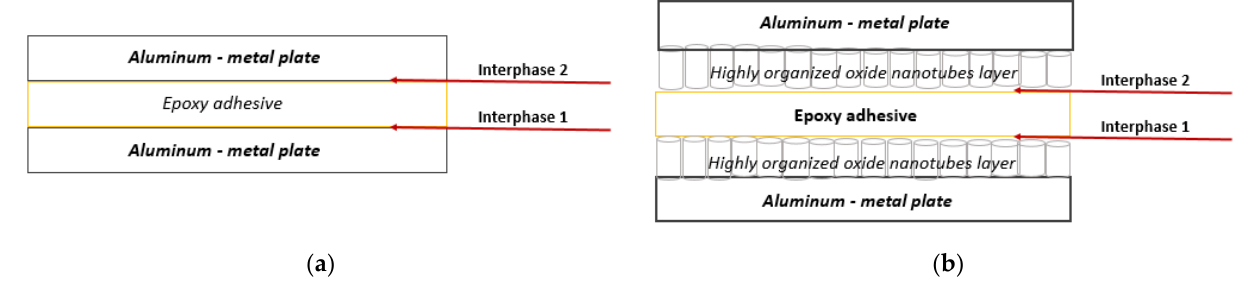
Figure 2. Schematic representation of the layers which form the interphases in the overlap area in ( a ) joints with non- anodized adherends and ( b ) joints with anodized adherends.